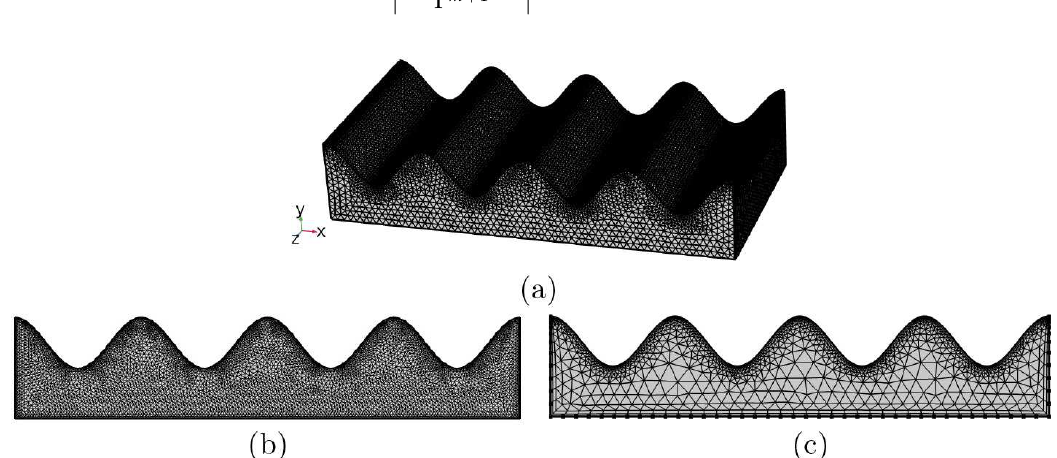
Figure 2. ( a ) 3D grid-points distribution for grid size of 364,856 elements, ( b ) 2D grid-points distribution for grid size of 9463 elements and ( c ) 2D grid-points distribution for grid size of 2367 elements in the plane ( X , Y